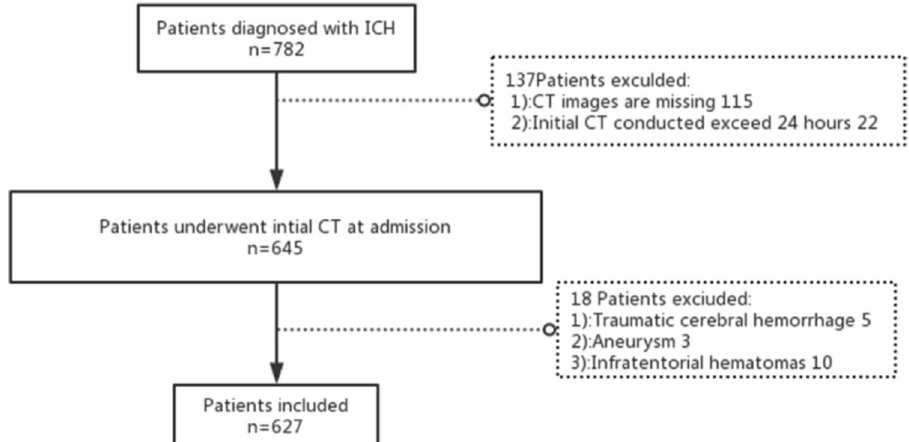
Figure 1. Flowchart of patient enrollment.